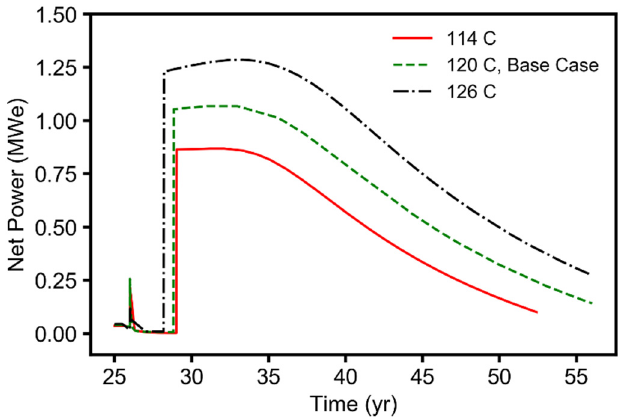
Figure A3. Simulation results (time-series plots) for the reservoir permeability parameter, showing the geothermal net power generated during the EGR and CPG stages (25–55 years).